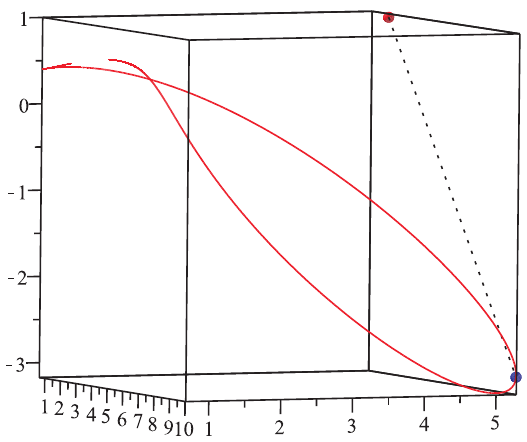
Figure 8. Geometric illustration for the first case of Example 2.